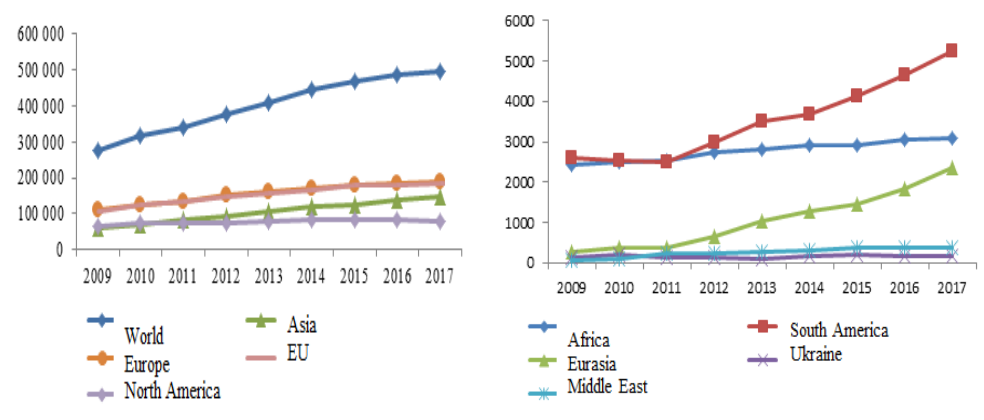
Fig. 1. Bioenergy production, GW, global trends.